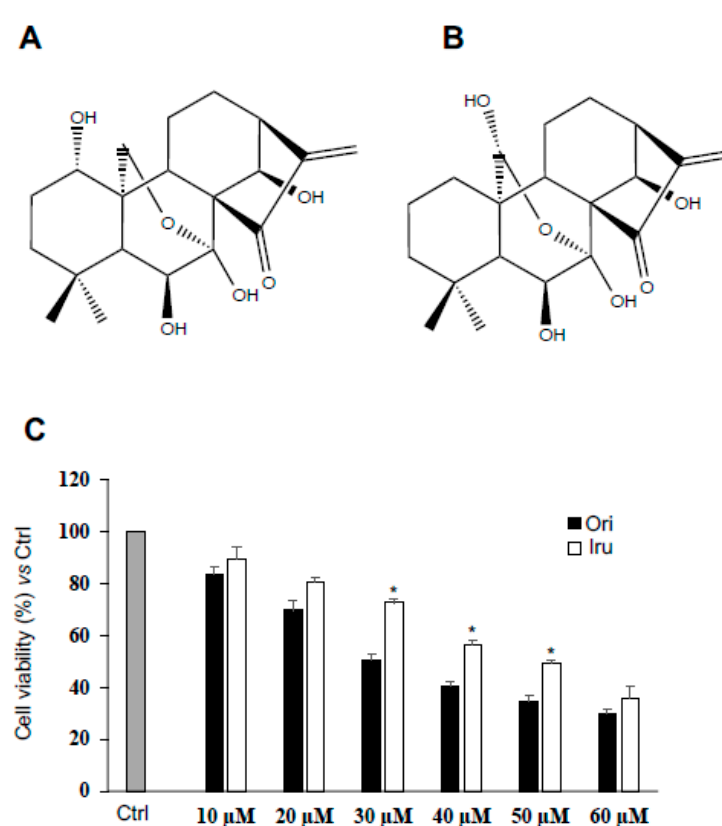
Figure 1. Effect of Ori and Iru exposure on C2C12 cell proliferation. ( A ) Chemical structure of Oridinin (Ori) ((1S,2S,5S,8R,9S,10S,11R,15S,18R)-9,10,15,18-tetrahydroxy-12,12-dimethyl-6-methylidene-17- oxapentacyclo (7.6.2.15,8.01,11.02,8) octadecan-7-one). ( B ) Chemical structure of Irudonin (1S,2S,5S,8R,9S,10S,11R,15S,18R)-9,10,17,18-tetrahydroxy-12,12-dimethyl-6-methylidene-17- oxapentacyclo (7.6.2.15,8.01,11.02,8) octadecan-7-one) ( C ) Results of cell proliferation assay on C2C12 cells. Cells were exposed to increasing concentration of Ori and Iru ranging from 10 to 60 µM as indicated for 24 h and then incubated with (PB) reagent at 10% final concentration for 1 h. Histograms represent percentage (mean ± SD) ( n = 6) of the control cells, cultured in DMEM with 0.1% DMSO, set as 100%. Columns with (*) were statistical significantly different from Ori treated cells (* p < 0.05).